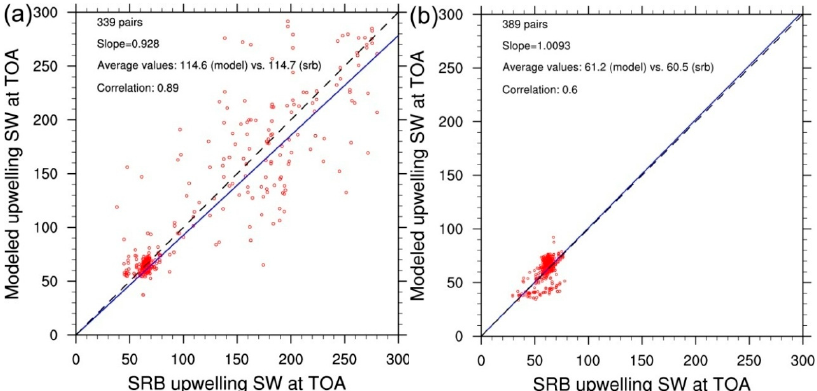
Figure 4. ( a ) Scatter plot of modeled daily SW TOA ↑ versus SRB daily SW TOA ↑ (unit: W/m 2 ) for the model grids with cloud fraction close to SRB cloud fraction (~ ± 0.05); ( b ) scatter plot of modeled daily SW TOA ↑ versus SRB daily clear-sky SW TOA ↑ (unit: W/m 2 ). Dashed line and solid line represent 1:1 line and regression line,